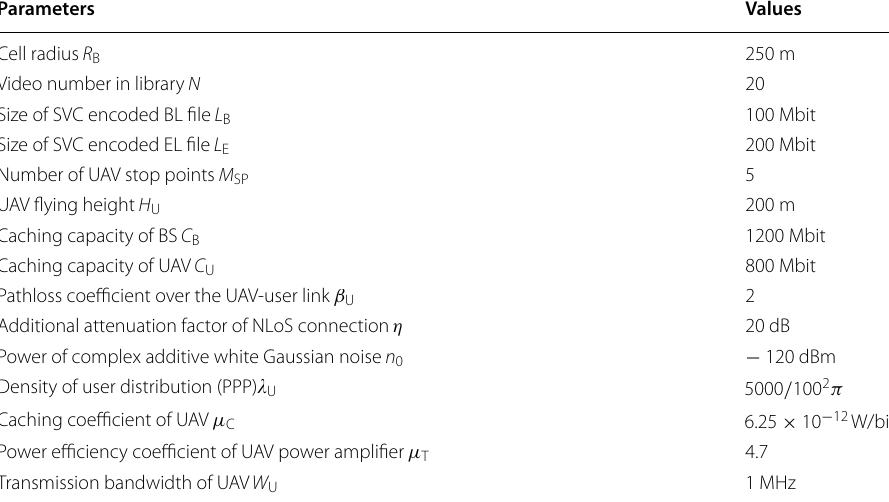
Table 2 The parameter setting of the network